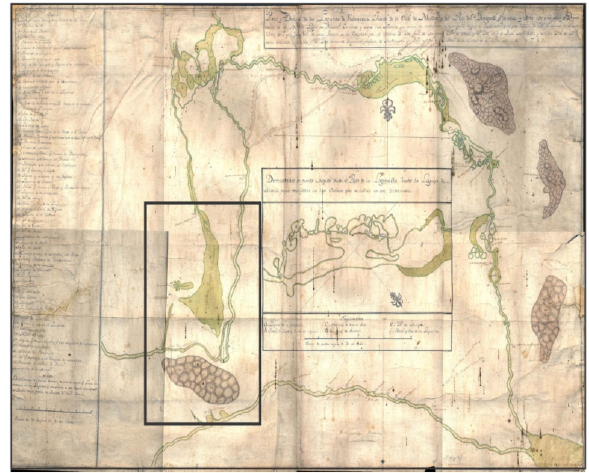
Fig. 2. Map of the Bermejo Swamp and Guanacache Lagoons by Jim´enez Inguanzo in 1789. In blackbox is marked the swamp (AGI, Maps and Plans, Buenos Aires, 336,